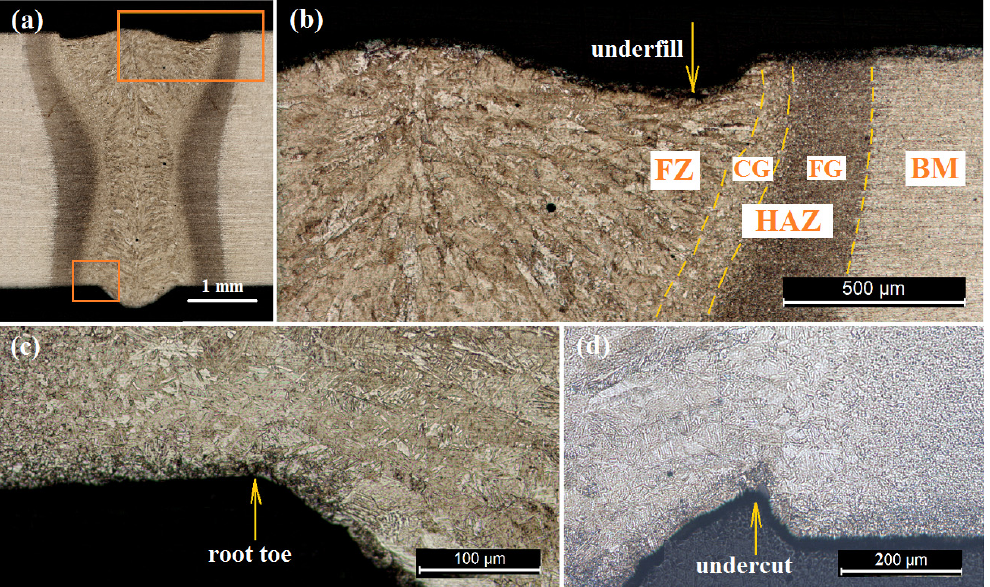
Figure 2. Metallographic and morphologic analyses. ( a ) S1 series macrograph, ( b ) Metallographic analysis and underfill defect, ( c ) toe of weld root, ( d ) undercut defect.